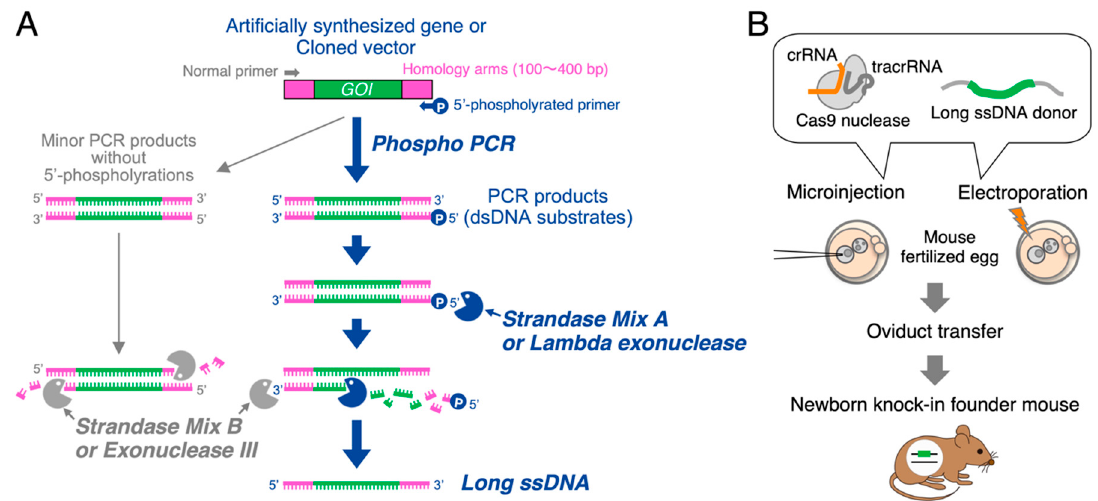
Figure 1. Schematic diagram of knock-in mouse generation using long ssDNA donors prepared by the phospho-PCR method. ( A ) Flowchart of the phospho-PCR method. A dsDNA template containing a gene cassette of interest (GOI) flanked by homology arms on both sides is depicted at the top. A pair of normal primer and 5 ′ -phospholyrated primer for PCR is used to amplify the starting dsDNA substrates for exonuclease reactions. Strandase Mix A or Lambda exonuclease selectively degrades the phosphorylated chains of the duplex. Strandase Mix B or Exonuclease III subsequently help complete the selective degradations to yield long ssDNAs. Minor PCR products without 5 ′ -phosphorylations are also extensively digested by Exonuclease III activities, whose efficiency is detailed in Results Section 3.2. Note that this sequential use of two exonucleases enables highly pure ssDNA production. ( B ) Schematic of CRISPR/Cas9 mediated knock-in mouse generation using long ssDNA donors. Long ssDNA donor and Cas9-guide RNA complex can be introduced into mouse fertilized eggs either by pronuclear injection or by electroporation. Treated eggs are transferred into the oviduct of pseudo-pregnant recipients to obtain knock-in founders.